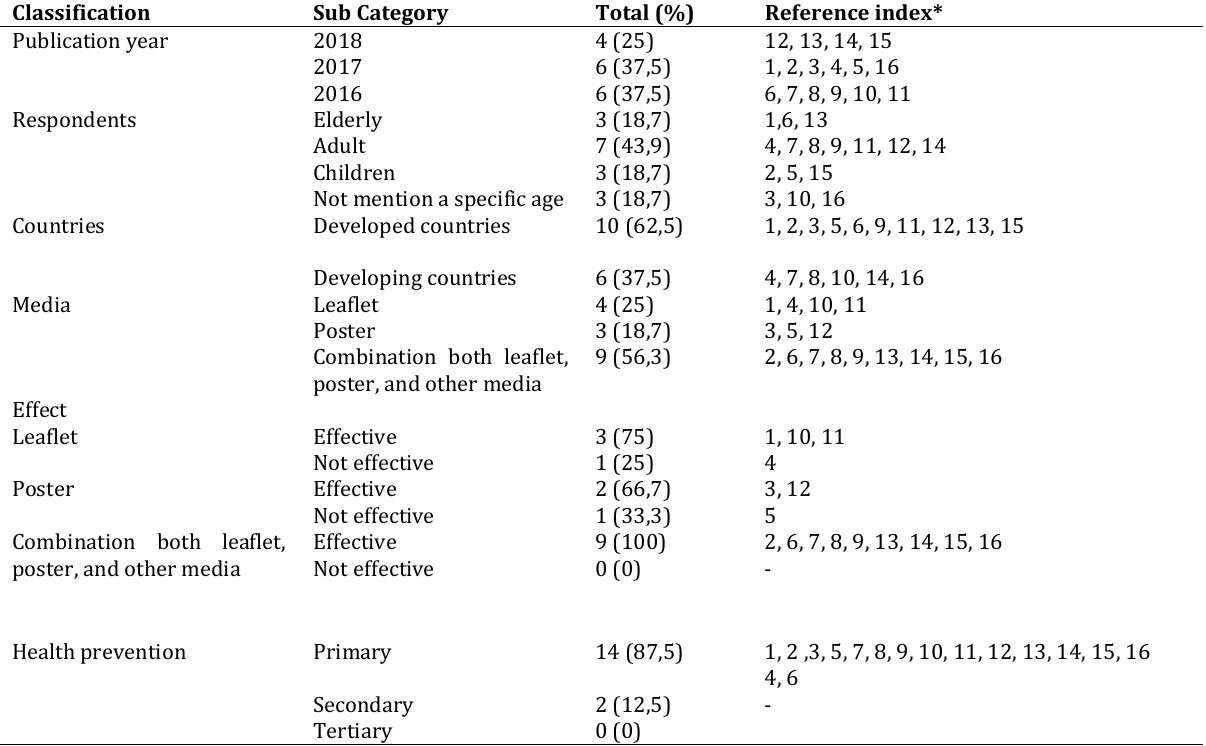
Table 1. The description of the relevant publications according to the analysis criteria